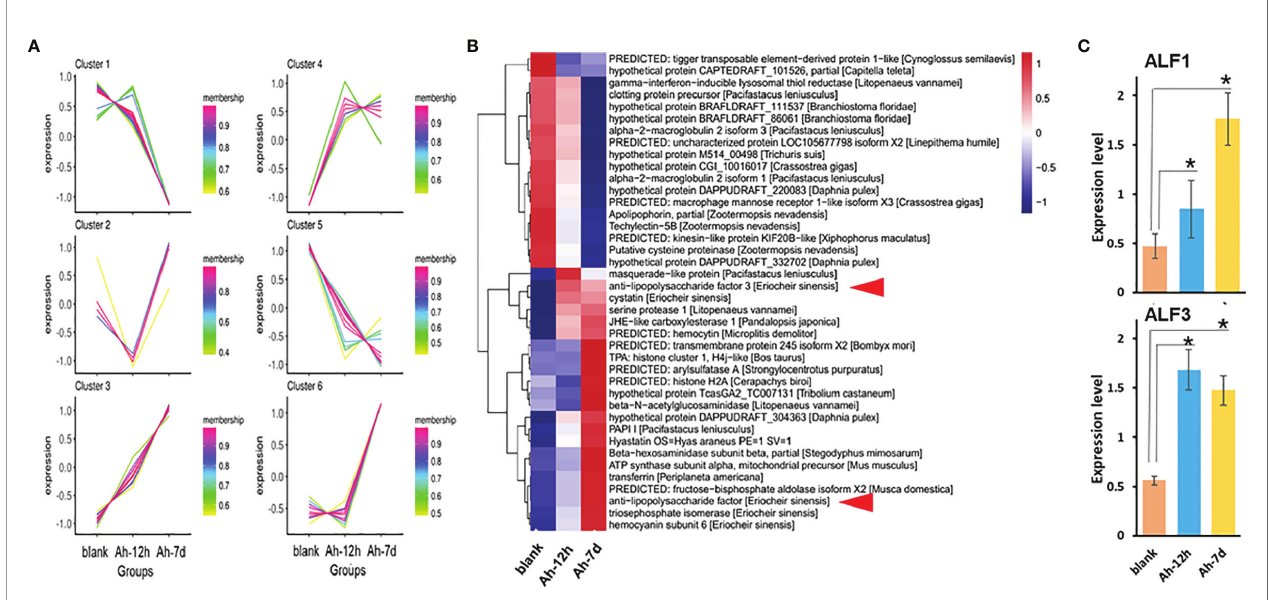
FIGURE 4 | Anti-lipopolysaccharide factors (ALFs) identi fi ed in primed haemolymph by proteomic analysis. The cell-free haemolymph collected from blank (Blank) crabs or crabs received A. hydrophila priming stimulation at 12 hours (Ah-12h) and 7 days (Ah-7d) was analyzed by proteomics. A total of 70 differentially expressed proteins (DEPs) were identi fi ed with many metabolic or immune related components annotated. Based on their expression changes after A. hydrophila priming stimulation, there were six expression modules (A) of these DEPs, and the expression heatmap showed more than half of up-regulated DEPs (B) . Among them, two ALFs ( Es ALF-1 and Es ALF-3) were signi fi cantly up-regulated (C) . Vertical bars represent the mean ± S.D. (N = 3). *p < 0.05.